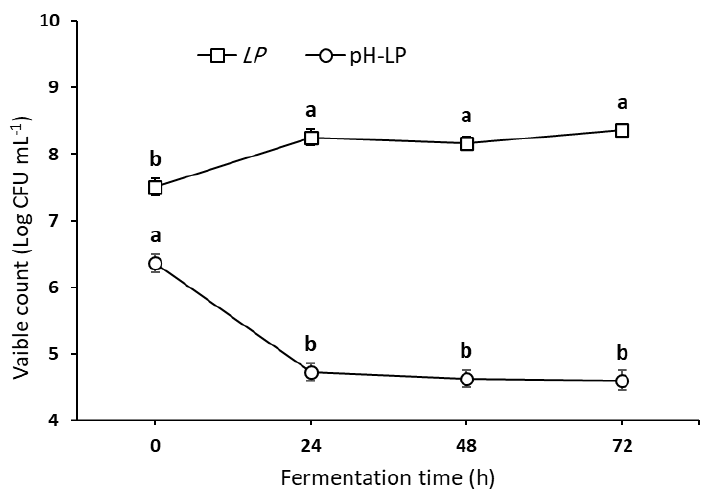
Figure 1. Viability of L. plantarum (CFU mL − 1 ) and pH value during oat fermentation (mean ± SE), n = 3. a, b , Lines during the fermentation period not sharing similar letters are significantly different ( p > 0.05).